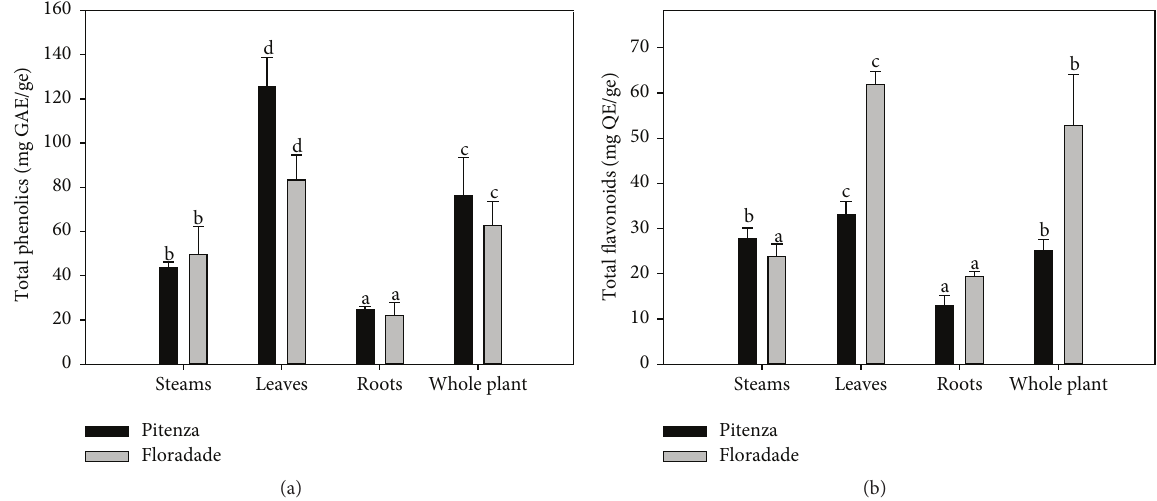
Figure 1: Total phenolic acids (a) and total flavonoids (b) in extracts of tomato plants. The data are mean values ± SD from at least three determinations. The mean values represented by the bars for each type of extract that are indicated with a different letter are significantly different ( P ≤ 0.05).